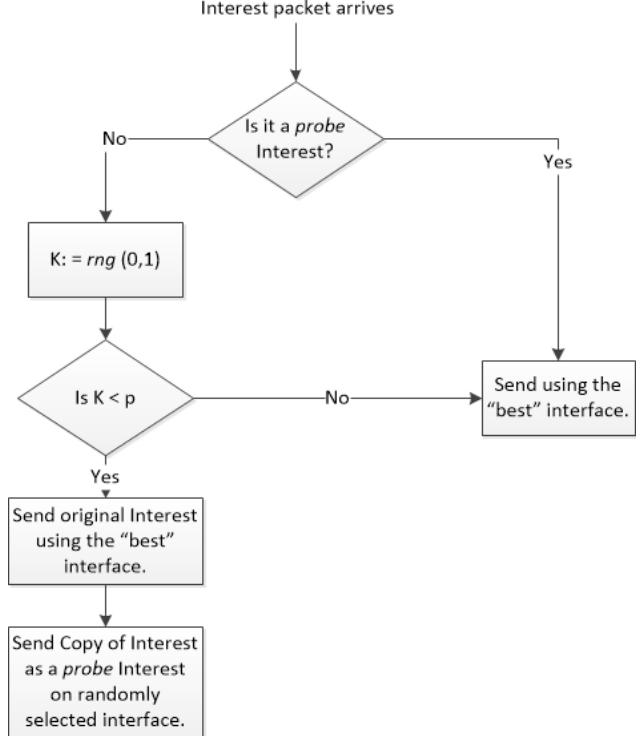
Figure 1. Interest forwarding and probing process of NDNFS-RLRNN. It uses the (cid:101) -greedy approach for the probing. rng (0,1) is a random number generator that returns a number in the range [ 0,1 ) . p is the probe parameter of the RNN. It is assumed that the RNN is no longer in its initial state and that forwarding is possible so that the best interface refers to the interface corresponding to the most excited neuron of the